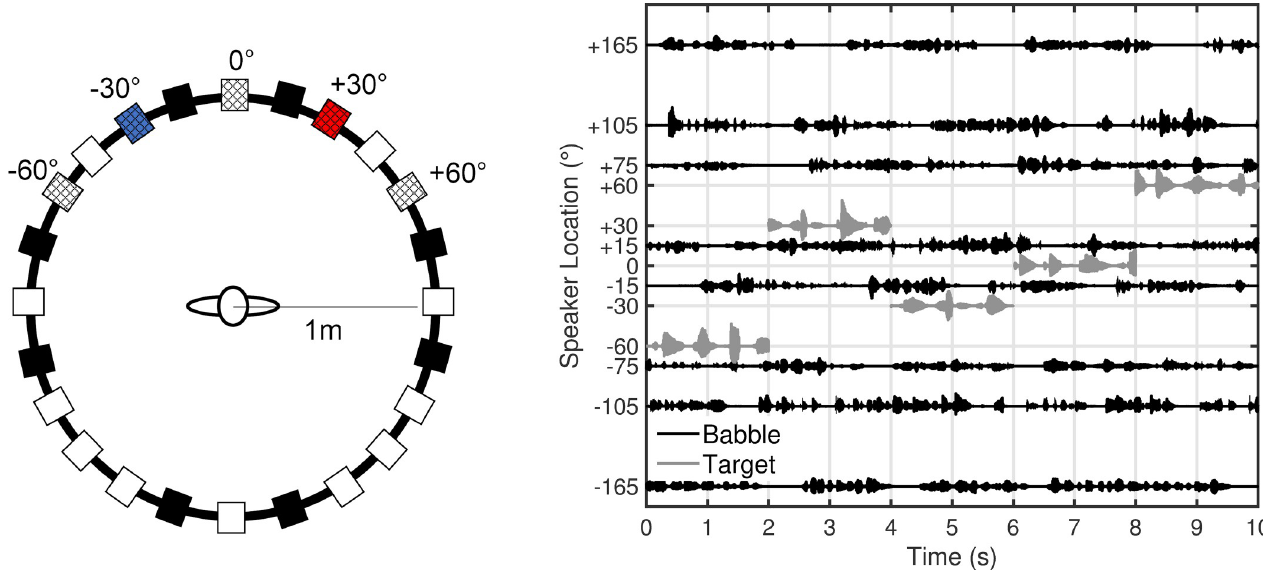
Fig 1. Panel A shows a schematic of the laboratory spatial array. The target speech stream came from alternate locations labeled, -60, -30, 0, +30, and +60˚. For the directed-attention conditions, listeners were instructed to either attend to the speaker at -30˚ (blue; Attend-30˚) or attend to the speaker at +30˚ (red; Attend+30˚). In Experiment I, the speech stream was presented in quiet. In Experiment II, the speech stream was presented in background speech babble at +6-dB SNR from 8 speaker locations (black boxes). Loudspeaker positions indicated by white boxes were not used in this study. Panel B shows a 10-second example presentation (Experiment II). Target (grey; 76 dB SPL) and babble (black; 70 dB SPL overall) waveforms are positioned at their respective speaker locations over time. The location of the target could change every 2 seconds. In Experiment I, only speech targets were